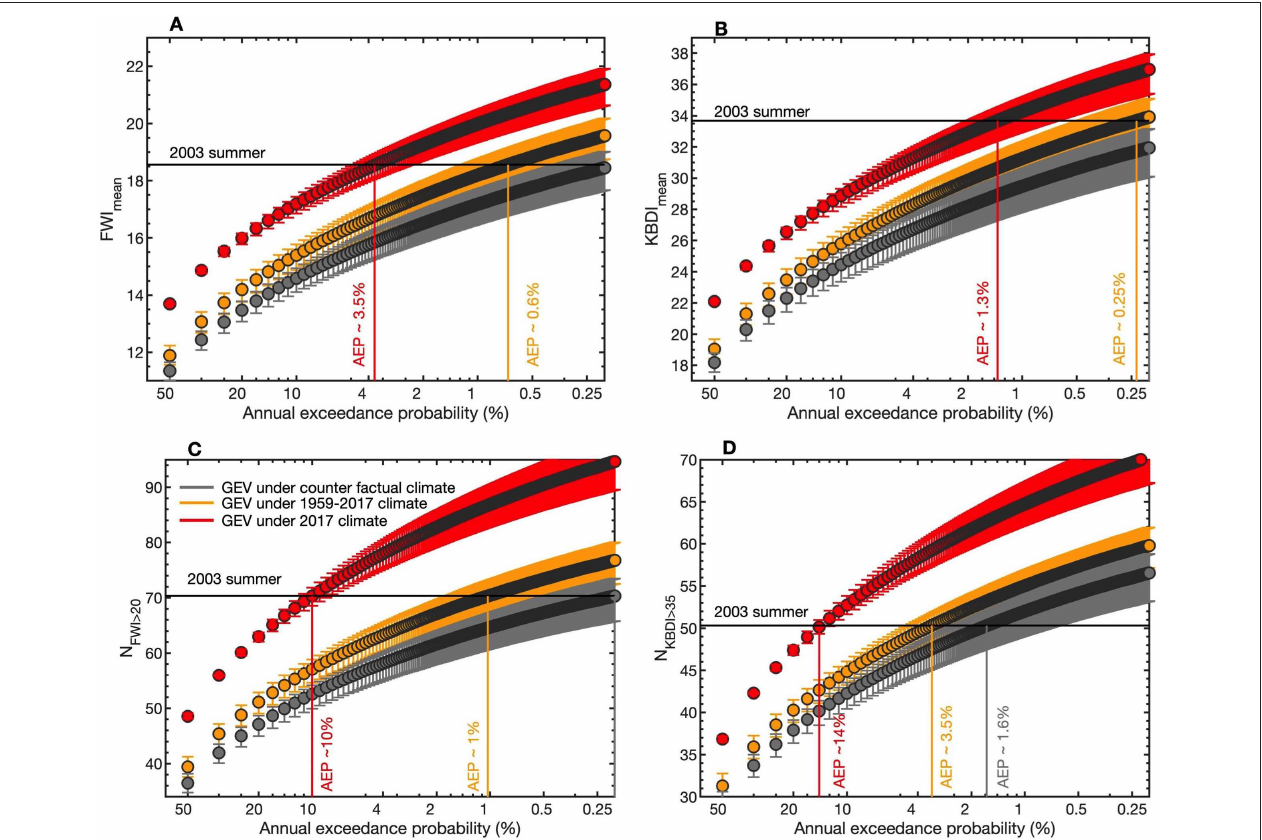
FIGURE 4 | (A) Return levels in the mean FWI from May to September averaged across the Mediterranean region for different annual exceedance probabilities (AEP) ranging from 50% (2-year return period) to 0.2% (500-year return period) estimated with a normal distribution using counterfactual observations as deduced from the multimodel mean (gray), observations under the stationarity assumption (orange), and observations under the non-stationarity assumption with the fitted trend to 2017 (red). The 95% confidence intervals were estimated using a bootstrapping approach. The black horizontal line denotes the level observed in 2003 and the vertical lines indicate the AEP in different fits (best estimate). (B) Same as (A) but for KBDI. (C) Same as (A) but for the annual number of occurrence of daily FWI>20 averaged across the Mediterranean region. In this case, the AEP has been estimated with a Weibull distribution. (D) Same as (C) but for the annual number of occurrence of daily KBDI>35.